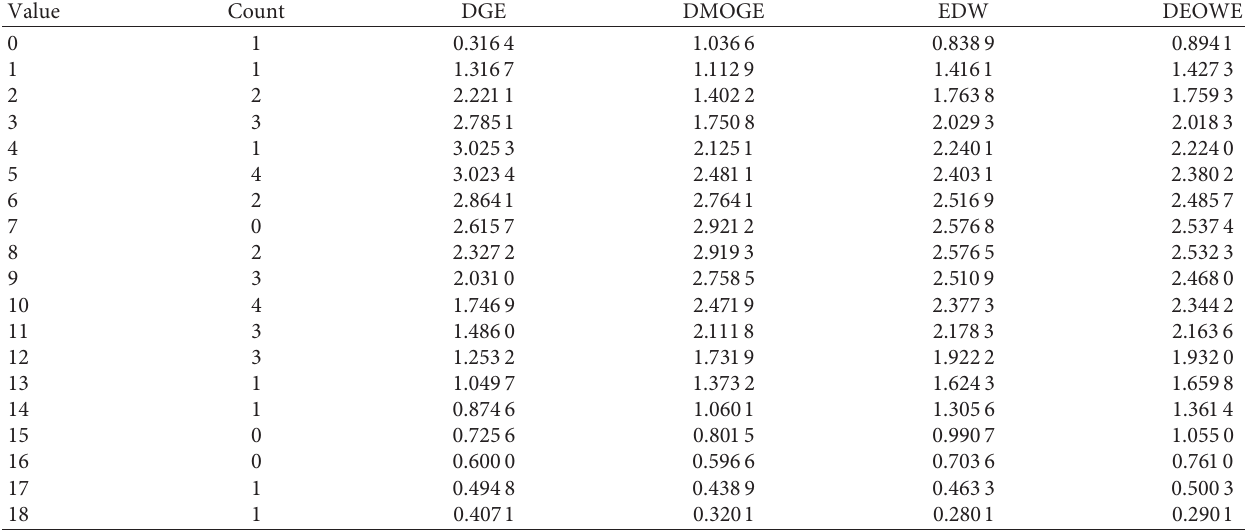
Table 10: The dataset used in this application associated with the frequency of each death number and the probability of this number. Value